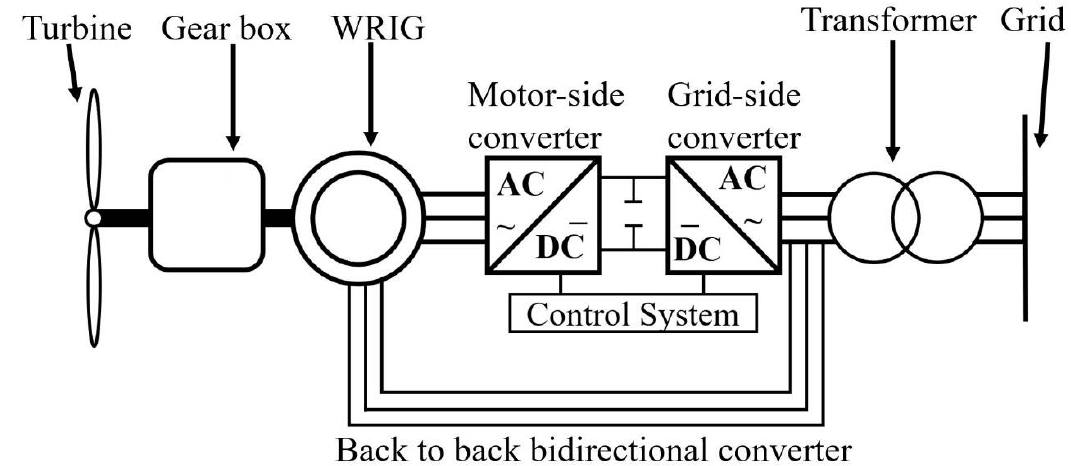
Figure 8. WRIG-based TCG system.